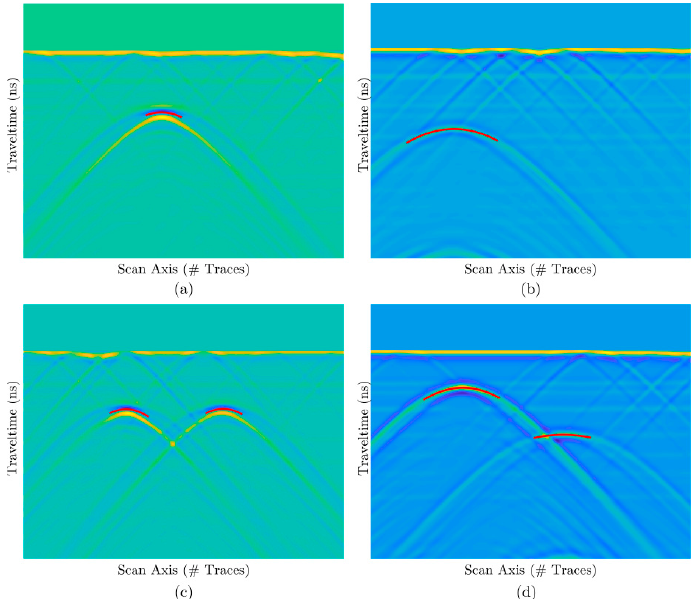
Figure 11. Hyperbolic fitting results in GPR B-SCAN images. ( a ) One air-filled target; ( b ) one water-filled target; ( c ) two air-filled targets; ( d ) two water-filled targets.